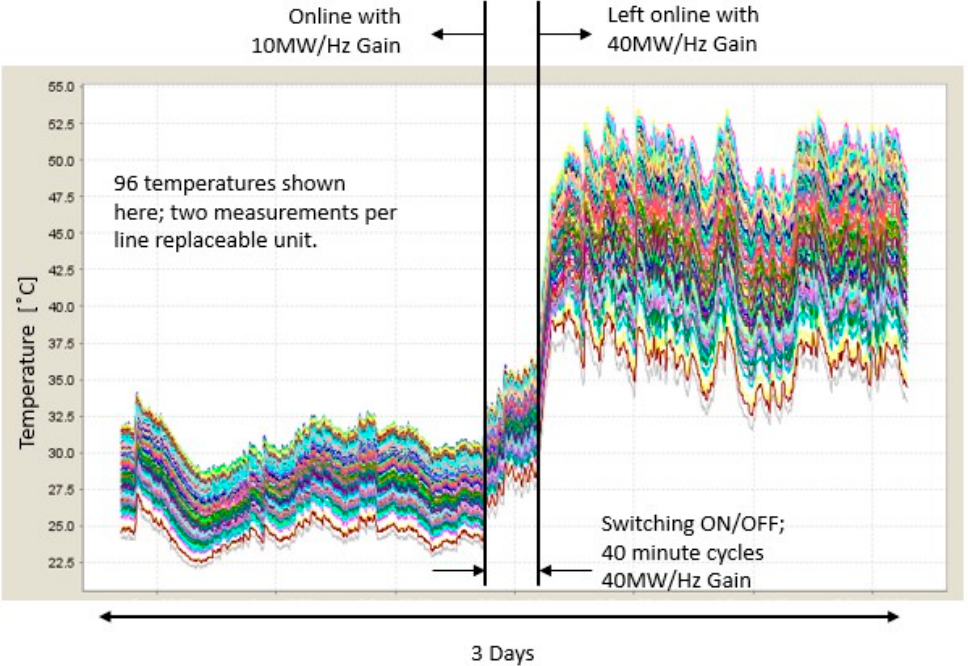
Figure 14. Time series of the temperature of battery modules (two groups of seven cells) over a three-day period when the gain setting of the frequency control algorithm was increased from 10 MW/Hz to 40 MW/Hz. The operating specification for these battery cells is between − 40 °C and +55 °C.